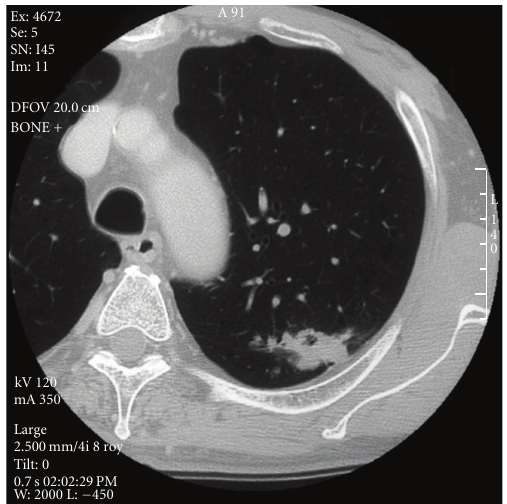
Figure 1: CT scanning of chest showing a lung cancer of 33 mm in the left S 1+2